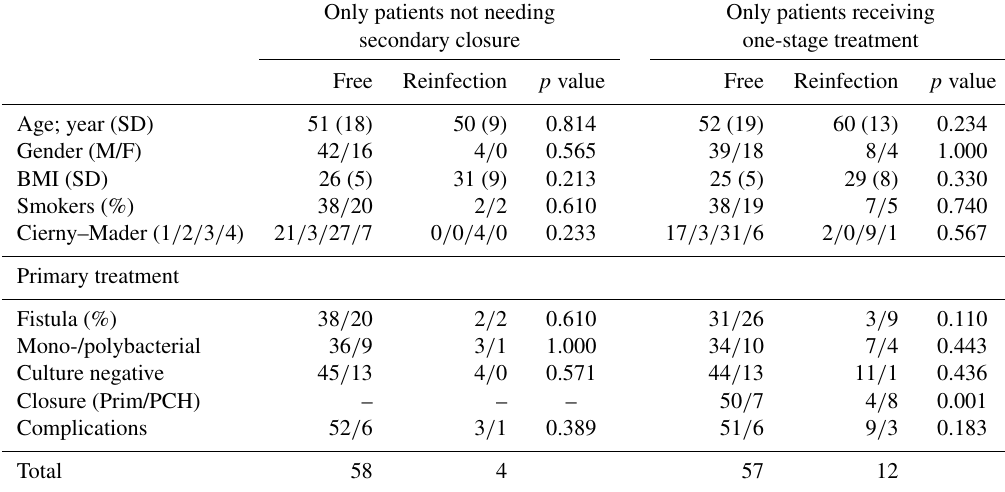
Table 6. Subgroup analysis on possible risk factors for recurrence of infection. Only patients not